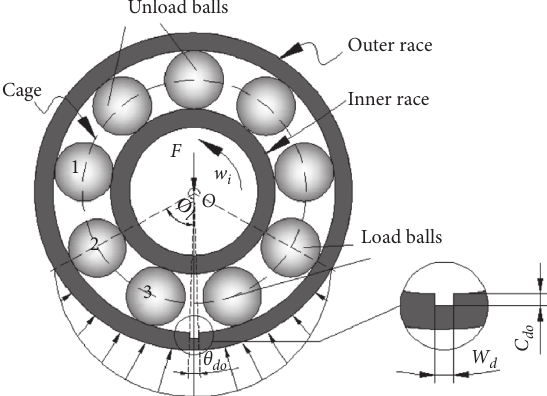
Figure 2: Schematic of bearing in load and unload zone.